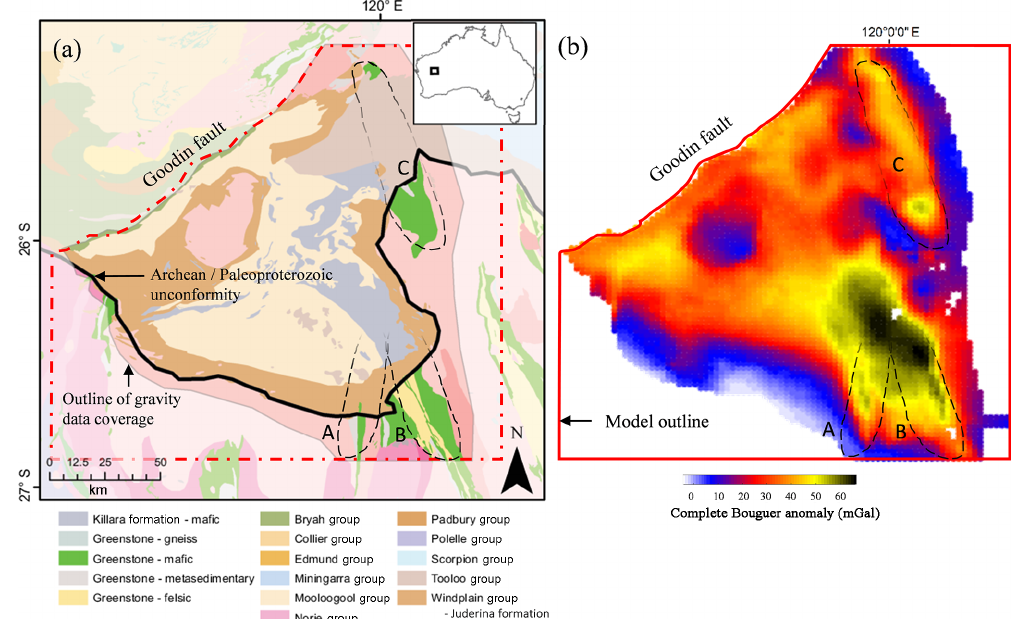
Figure 6. Geological context and geophysical data. (a) Geological map of the area and (b) complete Bouguer anomaly. The dashed lines delineate the possible sub-basin extent of the mafic greenstone belts